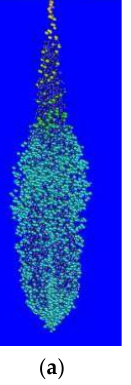
Figure 9. Comparison of the spray shape at 0.9 ms for Case 2. ( a ) Liquid-phase spray of simulation;